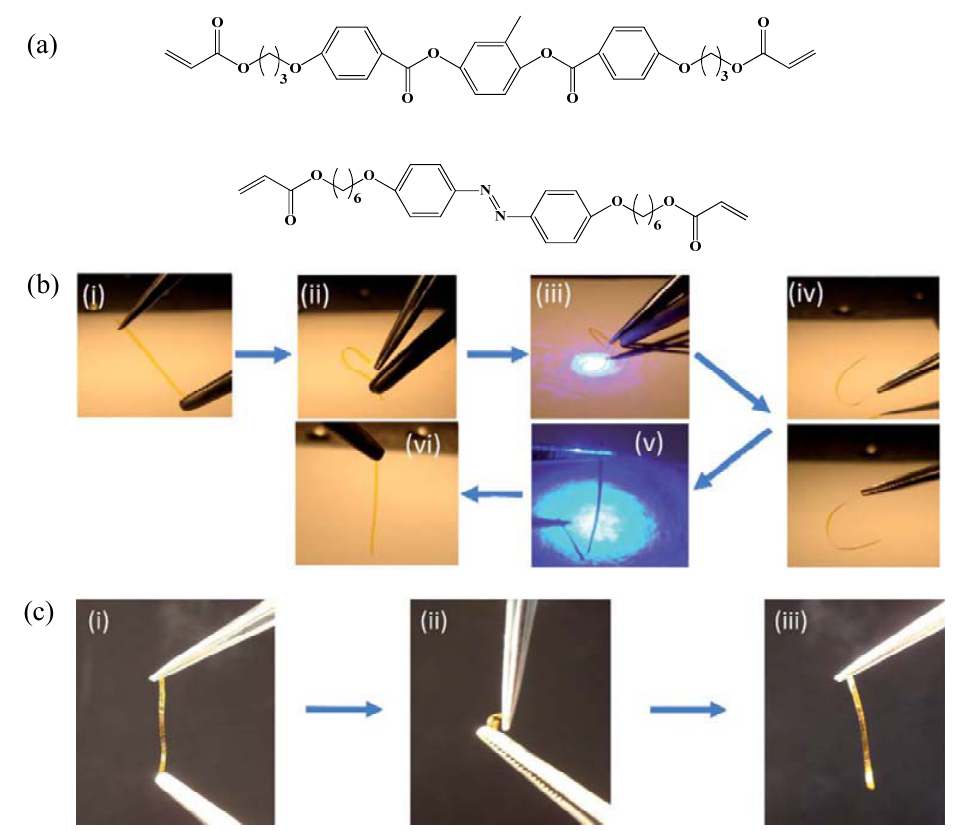
position. ( c ) Behavior of freestanding films without photo-fixing, (i) permanent shape, (ii) temporary shape mechanical deformation, without